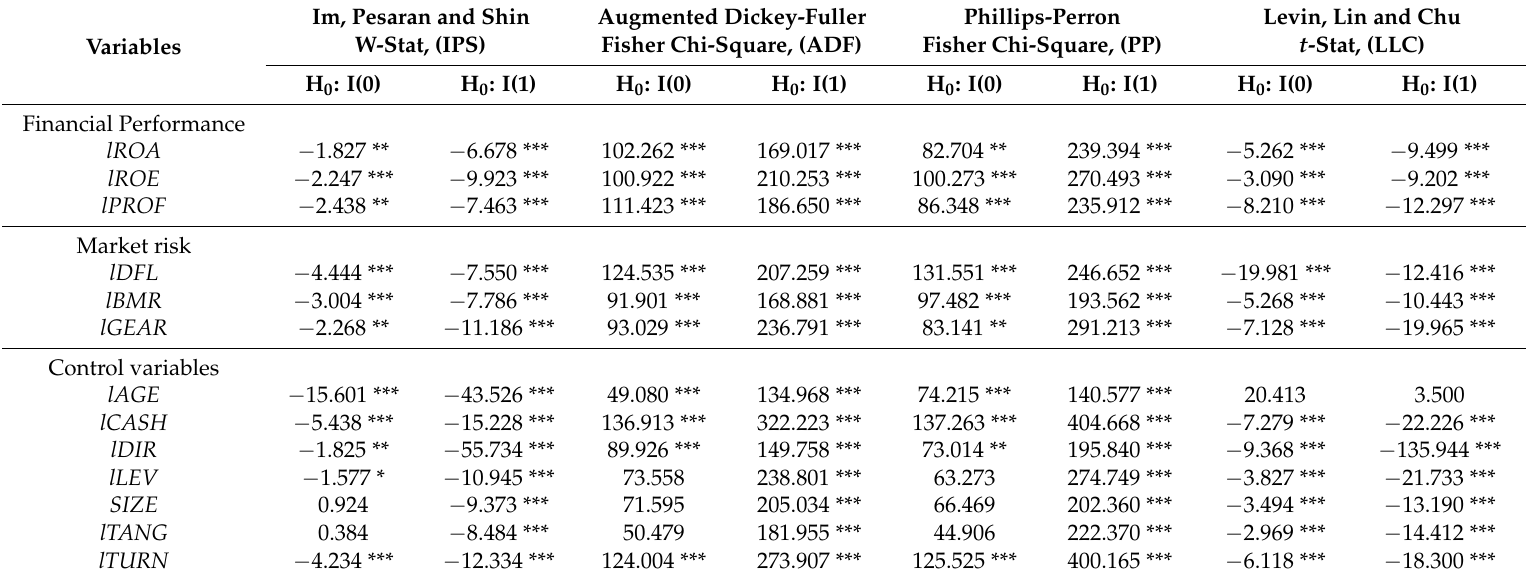
Table 3. Results of the unit root